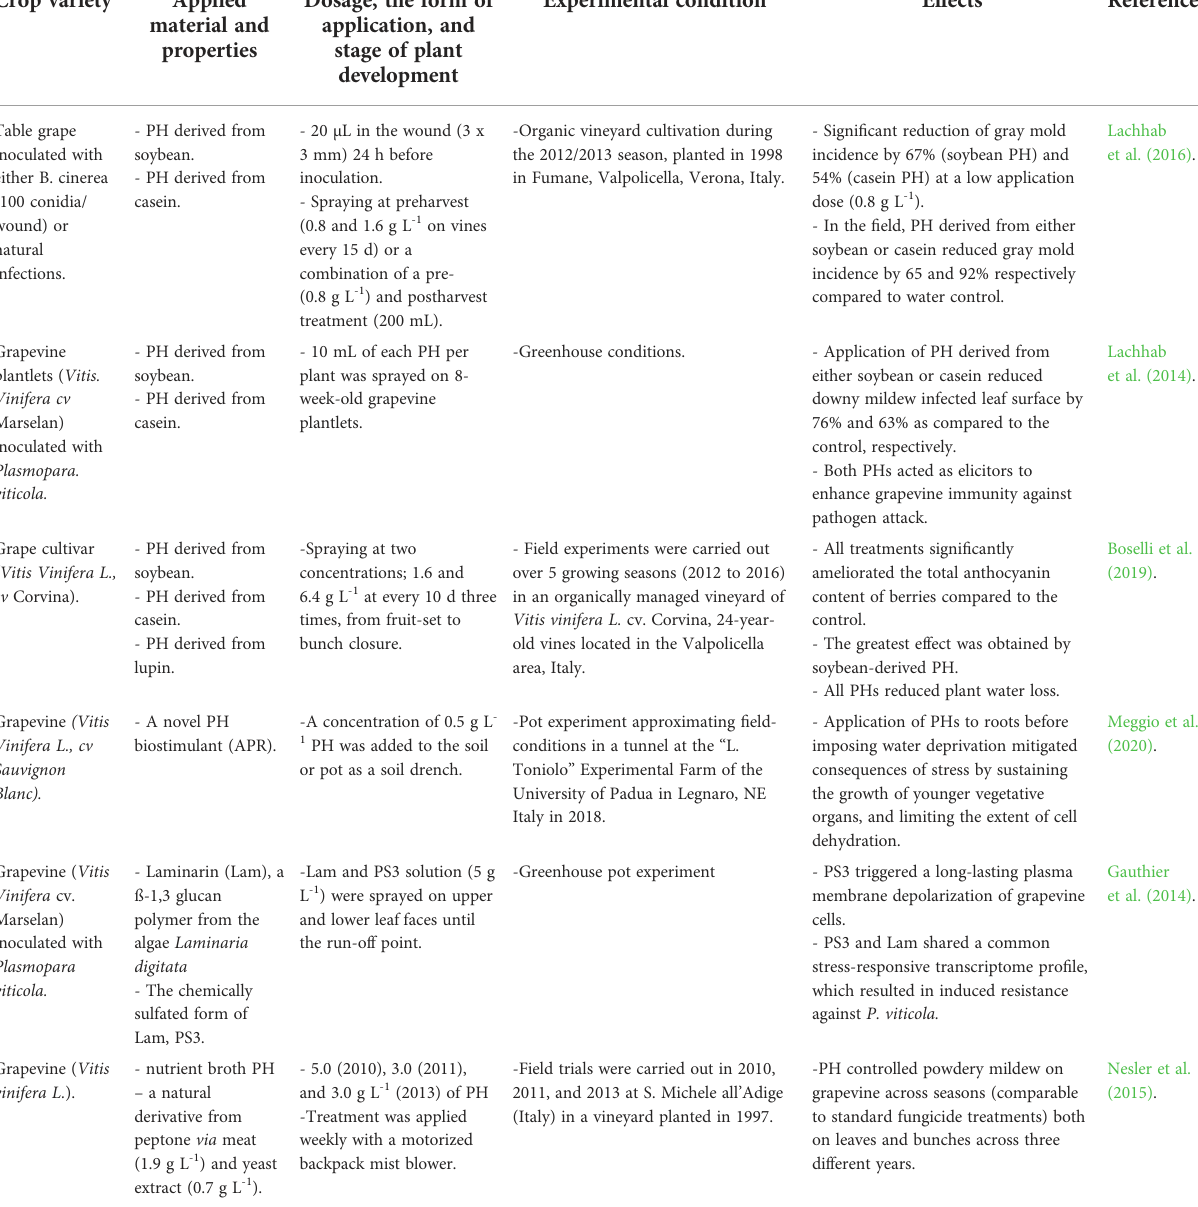
TABLE 1 An overview of the main effects of protein hydrolysates (PHs) applied in